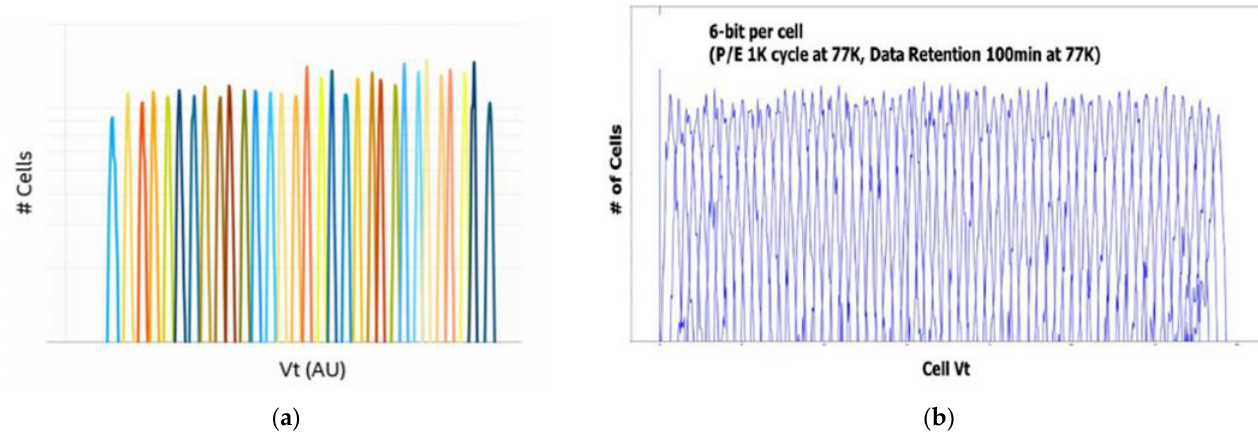
Figure 15. ( a ) PLC (5 bits per cell) Vth distribution with FG cell. ( b ) HLC (6 bits per cell) Vth placement with charge-trap cell at cryogenic temperature of 77 K. Reprinted with permission from refs. [45,46], Copyright 2020 and 2021 IEEE, respectively.